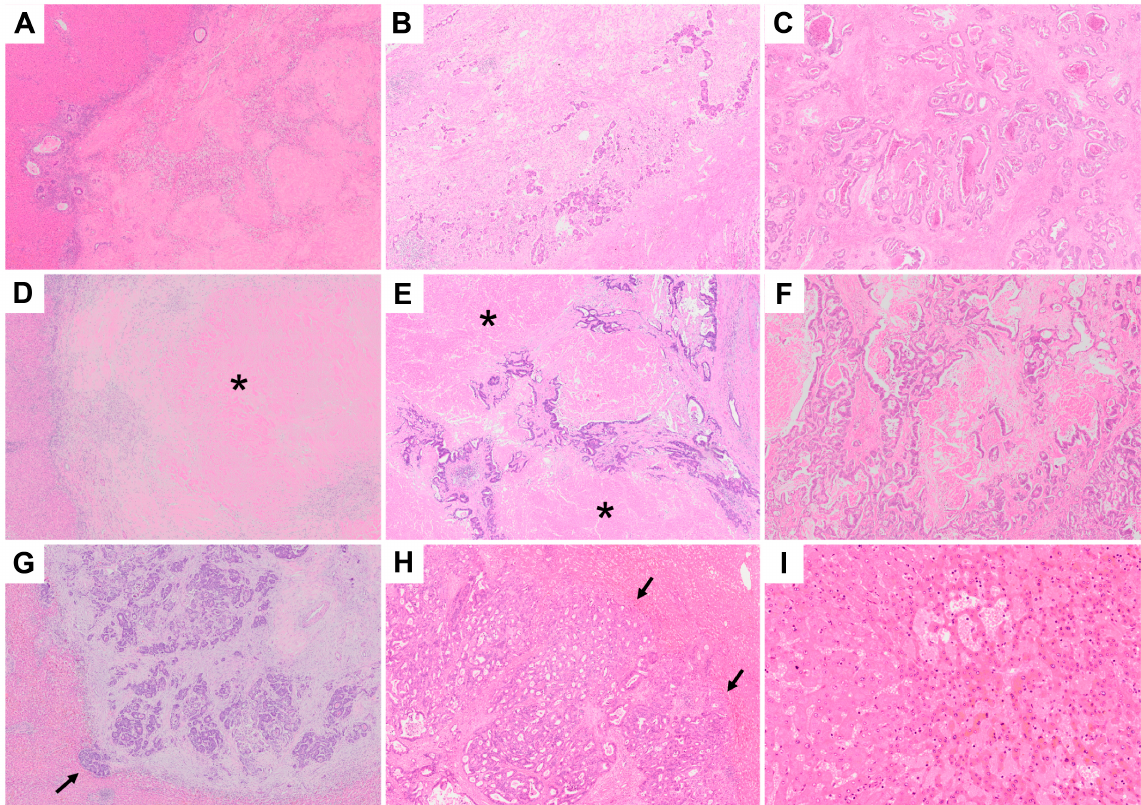
Figure 1. Representative histologic findings of colorectal liver metastases (( A – H ), original magnification ×20; ( I ), ×100). ( A – C ): Tumor regression grade (TRG). ( A – C ) correspond to TRG2 (low grade; mostly abundant fibrosis with a small number of viable tumor cells), TRG3 (low grade; predominantly fibrotic, but with more viable tumor cells), and TRG4 (high grade; more tumor cells than fibrosis), respectively. ( D – F ): Modified TRG (mTRG) considering the presence of infarct-like necrosis (ILN) (asterisk). ( D – F ) correspond to mTRG2 (low grade; mostly abundant fibrosis and ILN with a small number of viable tumor cells), mTRG3 (low grade; mainly fibrosis and ILN, but a larger number of viable tumor cells), and mTRG4 (high grade; more tumor cells than fibrosis and ILN), respectively. ( G ): “Rare” dangerous halo (scattered tumor cells that infiltrate the liver parenchyma for <10% of the lesion’s circumference) (arrows). ( H ): “Diffuse” dangerous halo (scattered cells that infiltrate the liver parenchyma for >50% of the lesion’s circumference) (arrows). ( I ): Sinusoidal obstruction syndrome grade 2 (moderate and extended from zone 1 to zone 2), which was observed in the background only in the cetuximab arm.